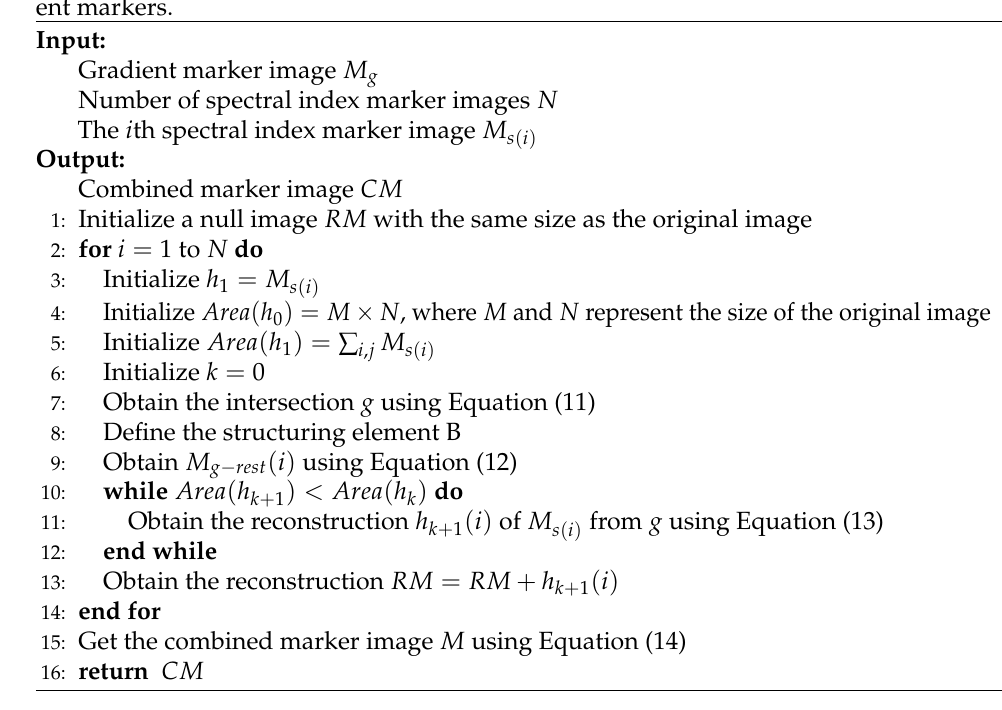
Algorithm 1 Generating a combined marker image based on spectral indices and gradi- ent